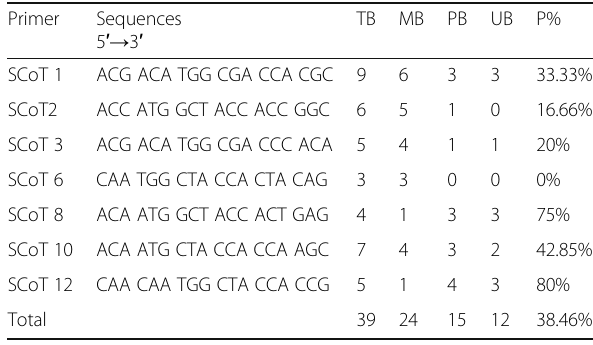
Table 5 Primer name, sequence, total number of bands, monomorphic bands, polymorphic bands, unique bands and percentage of polymorphism as revealed by SCoT markers among the three UV treatments and the control to